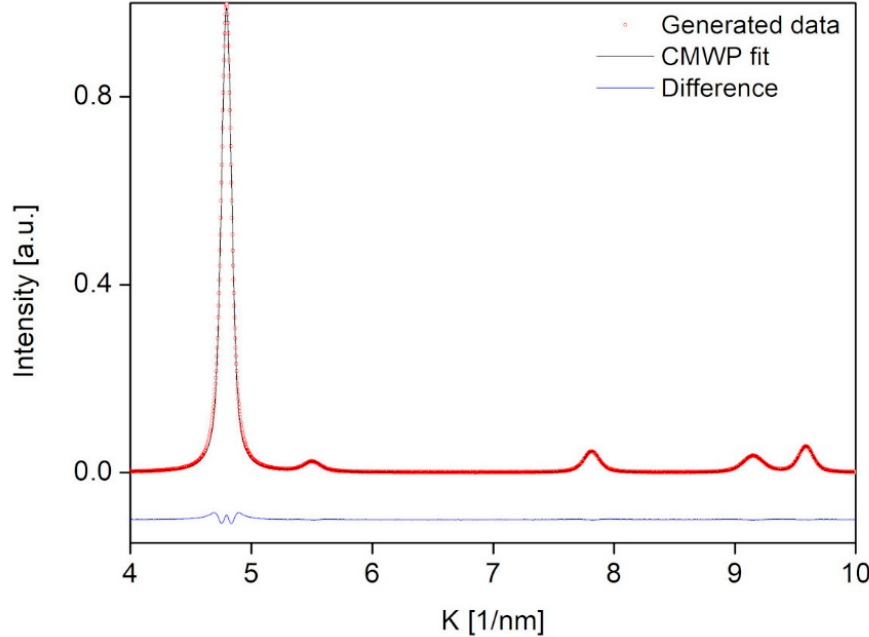
Figure 4. An FCC XRD pattern obtained by the method used for the production of the learning set (indicated by red circles). For validating the correct operation of the method, the calculated pattern was fitted by the CMWP method, which is illustrated by the black line in this figure. At the bottom, the difference between the calculated and the fitted patterns is also shown by blue line.